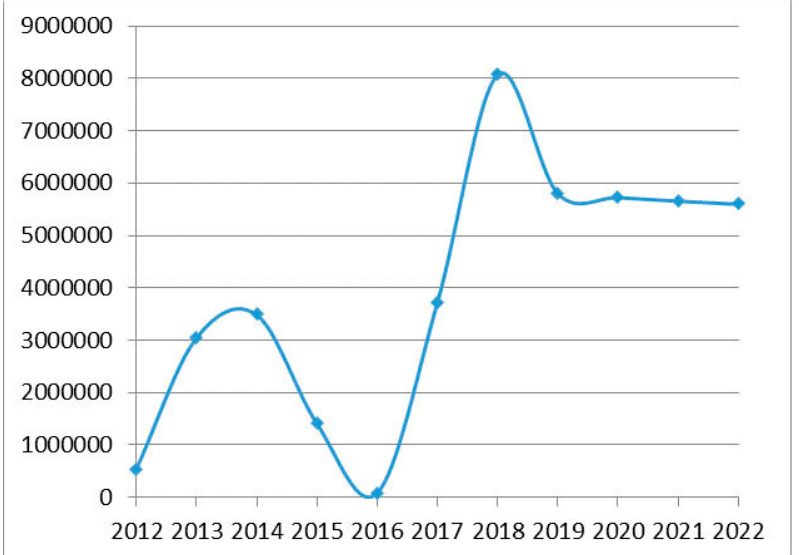
Figure 2. Forecast strategic values of net profit, in thousand rubles (developed by authors V.V. Manuylenko, A.I. Borlakova).